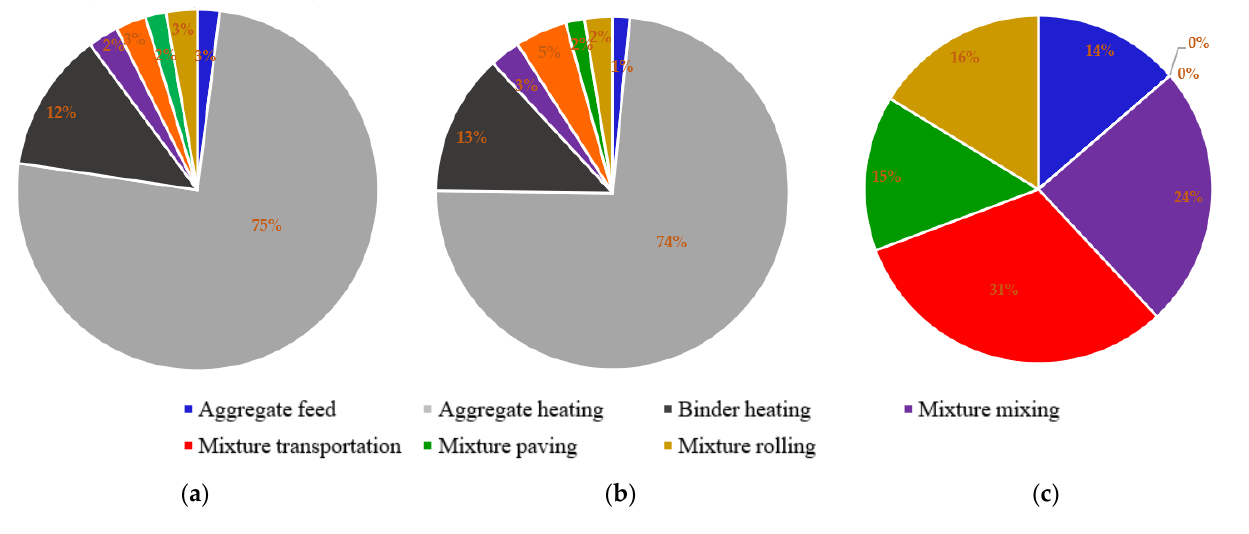
Figure 14. Energy consumption of pavement construction. ( a ) SMA-13; ( b ) SMA-20; ( c ) PUM-16.